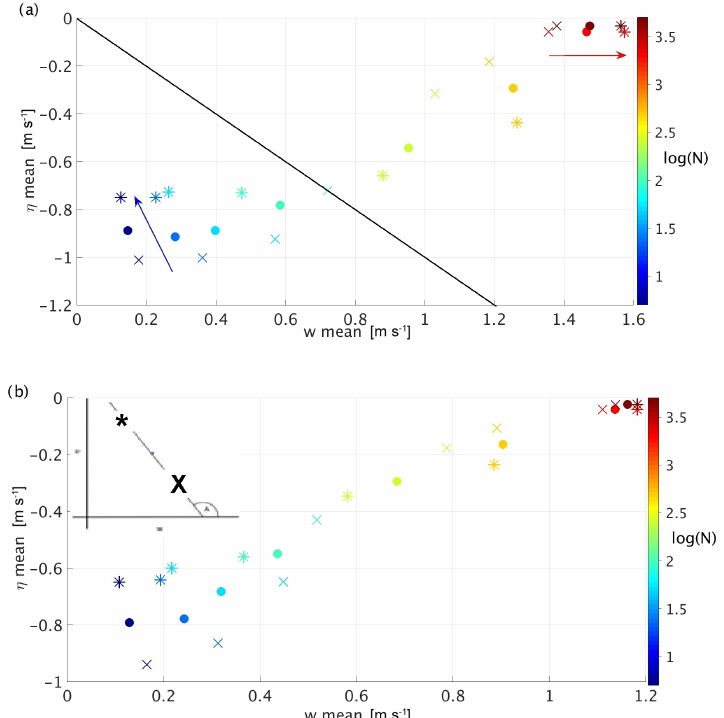
Figure 3. Temporal and spatial averages of the ambient air vertical velocity ( w ) vs. effective terminal velocity ( η ). Color coding denotes the different aerosol concentrations ( N [cm − 3 ]). Dots represent averages of the entire simulation data (excluding the first 2h spin-up time). The x and ∗ markers represent the first third (2 to 6h 40min) and last third (11h 20min to 16h) of the simulation period, respectively. (a) All clouds in the domain. (b) Only clouds in the growing stage. The black line in (a) is the zero-sum line for which V COG = 0 (below the line V COG <0 and above it V COG >0). The angle A that measures the η vs. w time trend per aerosol level is illustrated in the inset in (b)